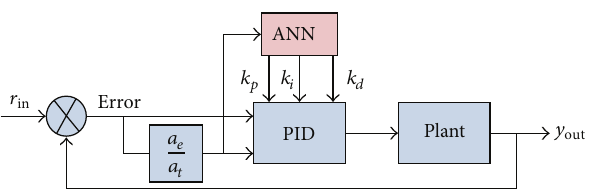
Figure 11: The structure diagram of the memristive neural network PID controller.